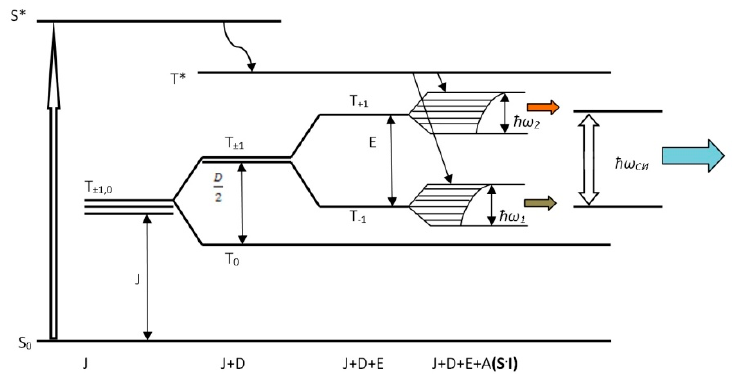
Figure 12. Energy diagram of population inversion of levels T +1 and T − 1 (the length of horizontal segments is proportional to the population of levels when splitting T +1 and T − 1 by the mechanism of spin–spin interaction) (From [48] with permission).